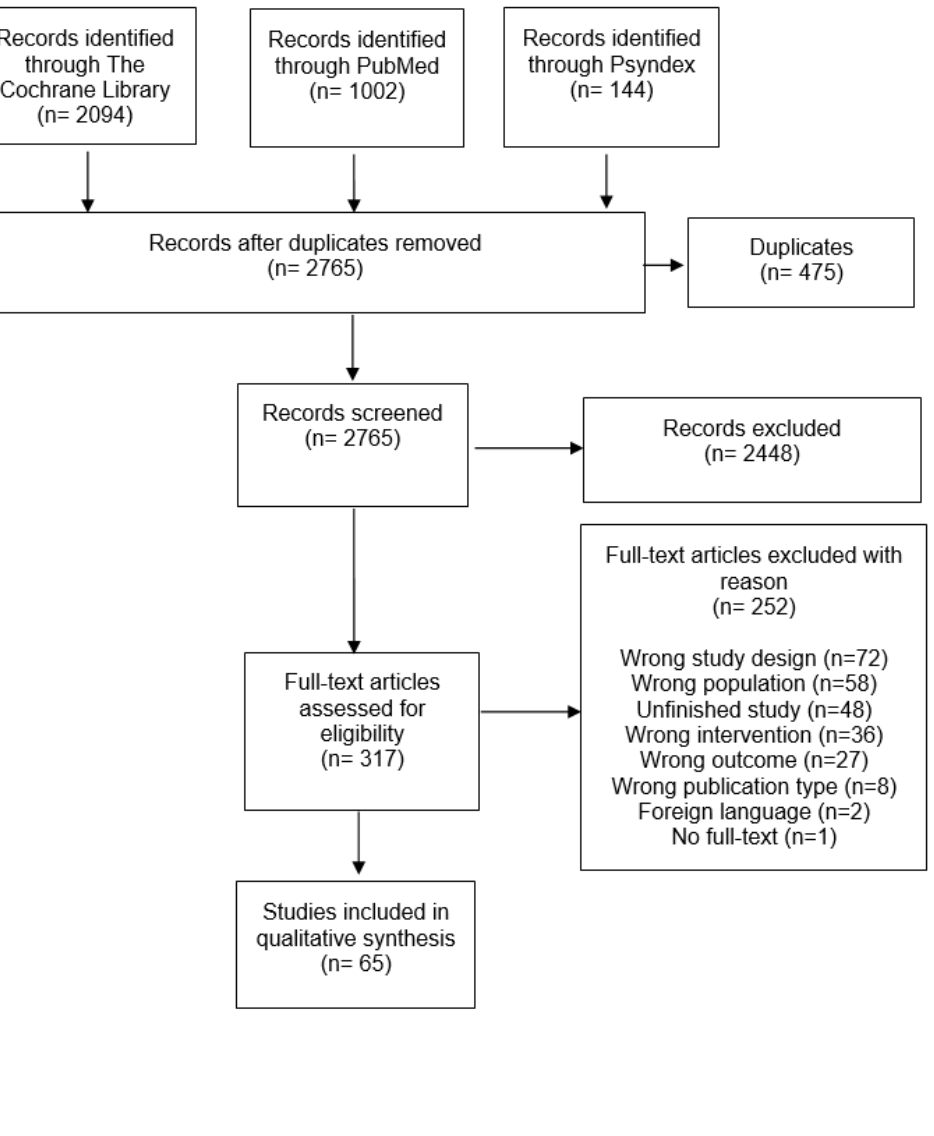
Figure 1. PRISMA flow diagram of literature search and selection process